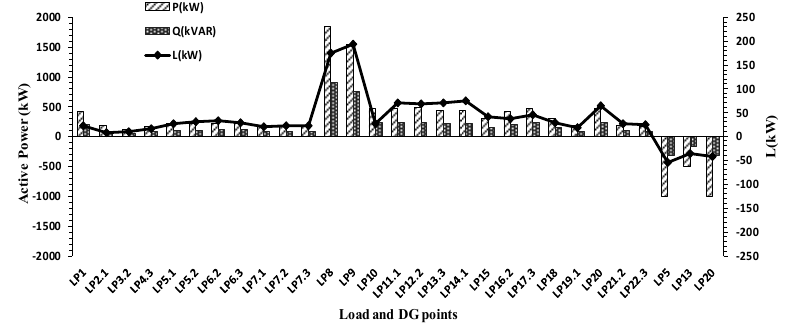
Figure 6. Allocated losses for the scenario when DGs are ignored .